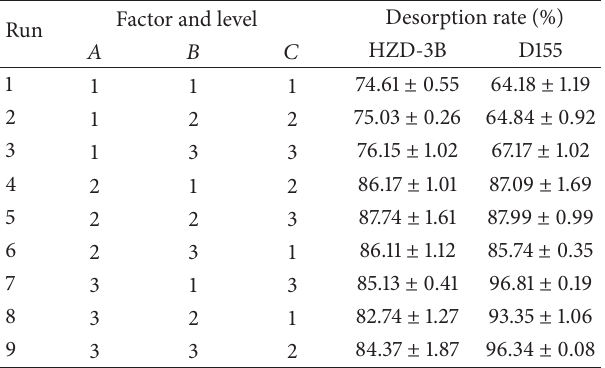
Table 5: The static 𝜀 -PL adsorption capacity and elution ratios of HZD-3B and D155